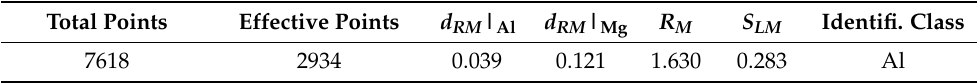
Table 4. Identification data of sample